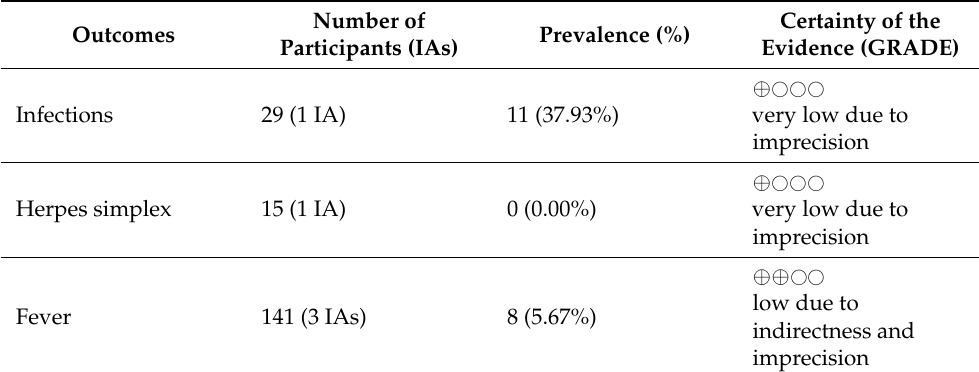
Table 10. Summary of ISO therapy adverse events: